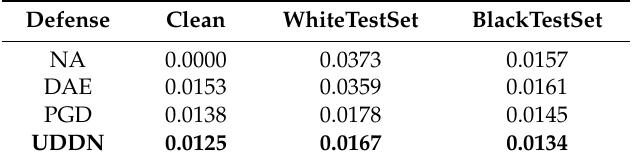
Table 1. The L1 distance between the input image and the denoised image.